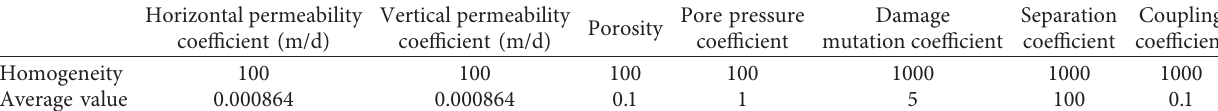
Table 3: Seepage parameters used in the numerical model.